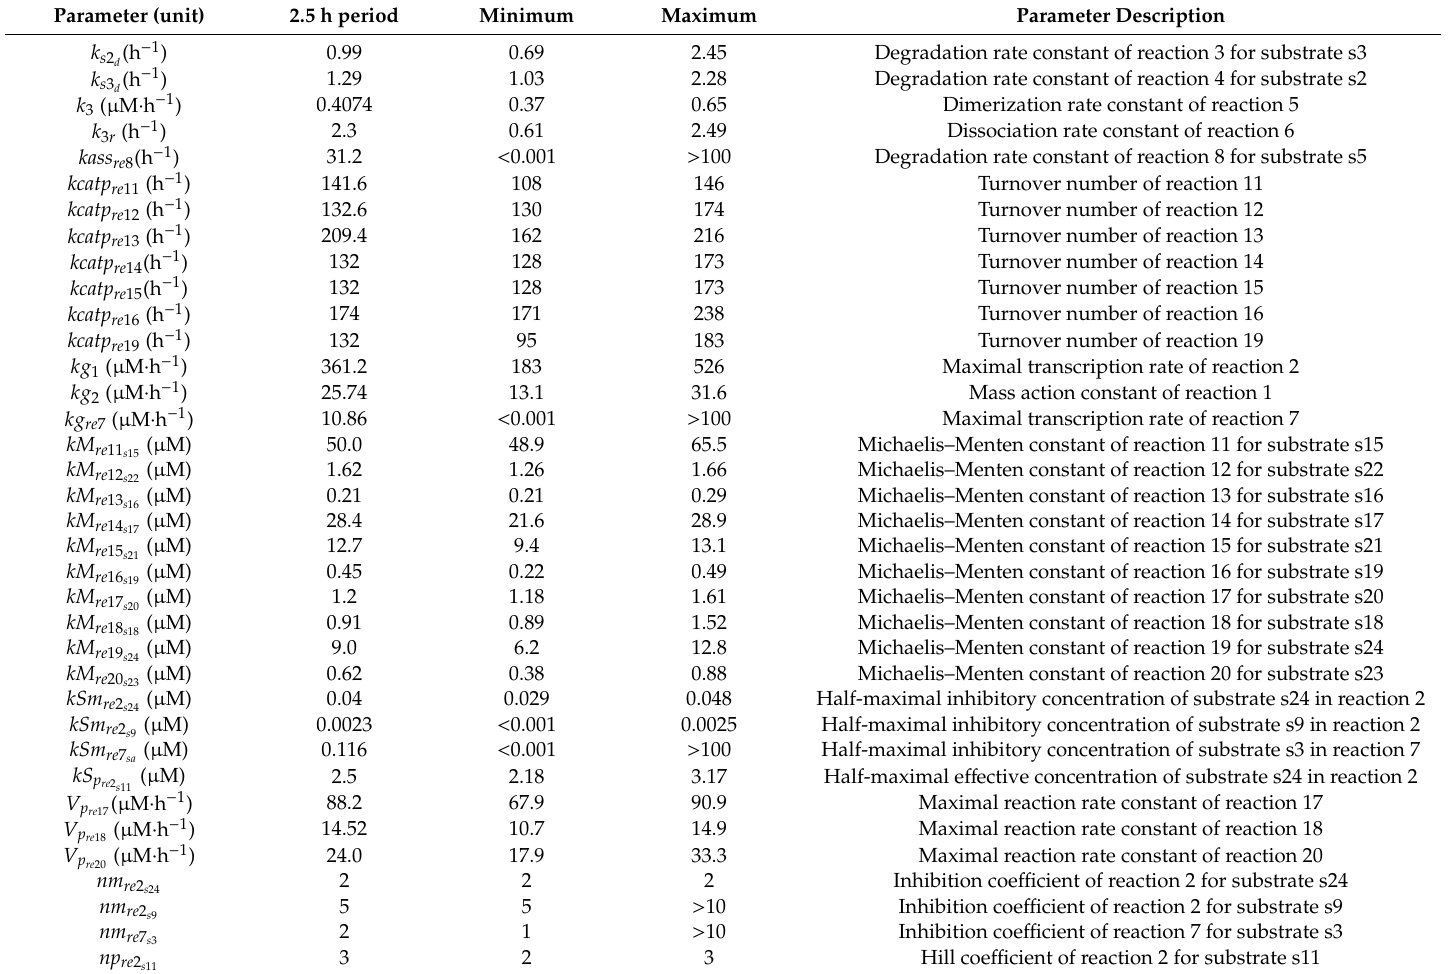
Table 2. Oscillation parameter